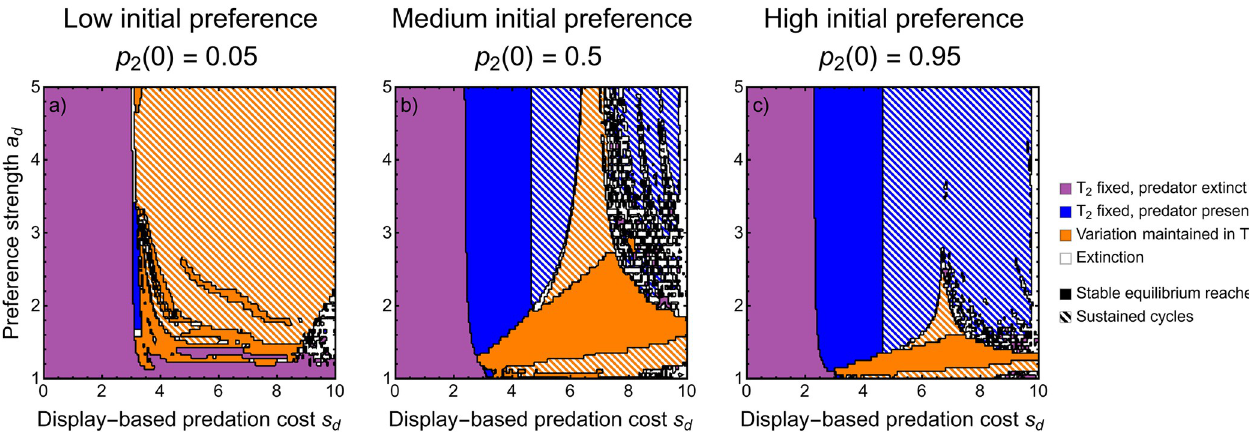
Fig 5. Eco-evolutionary outcomes from the Fisher process model. Parameters correspond to Fig 4C. Note that these are not equilibrium outcomes, but rather the outcome after 2,000 time steps, and thus cycles (striped regions) may not be sustained indefinitely. Apparent black regions are boundaries of two regions that have not been cleanly differentiated in 2,000 time steps. Solid color corresponds to a stable equilibrium being reached and striped corresponds to sustained or long transient cycles. Panels show different values for initial frequency of females with a preference (0.05, 0.5, and 0.95, moving left to right). This Figure can be generated using S1